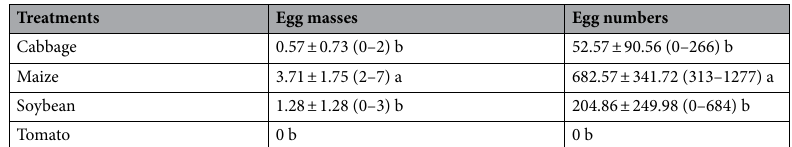
Table 1. Average number of egg masses and eggs (mean ± SD, min.–max. range) laid by females of the fall armyworm, Spodoptera frugiperda and recorded under a choice test on cabbage, maize, soybean and tomato. Means followed by the same letter(s) in a column are not significantly different ( P < 0.05) by Tukey’s